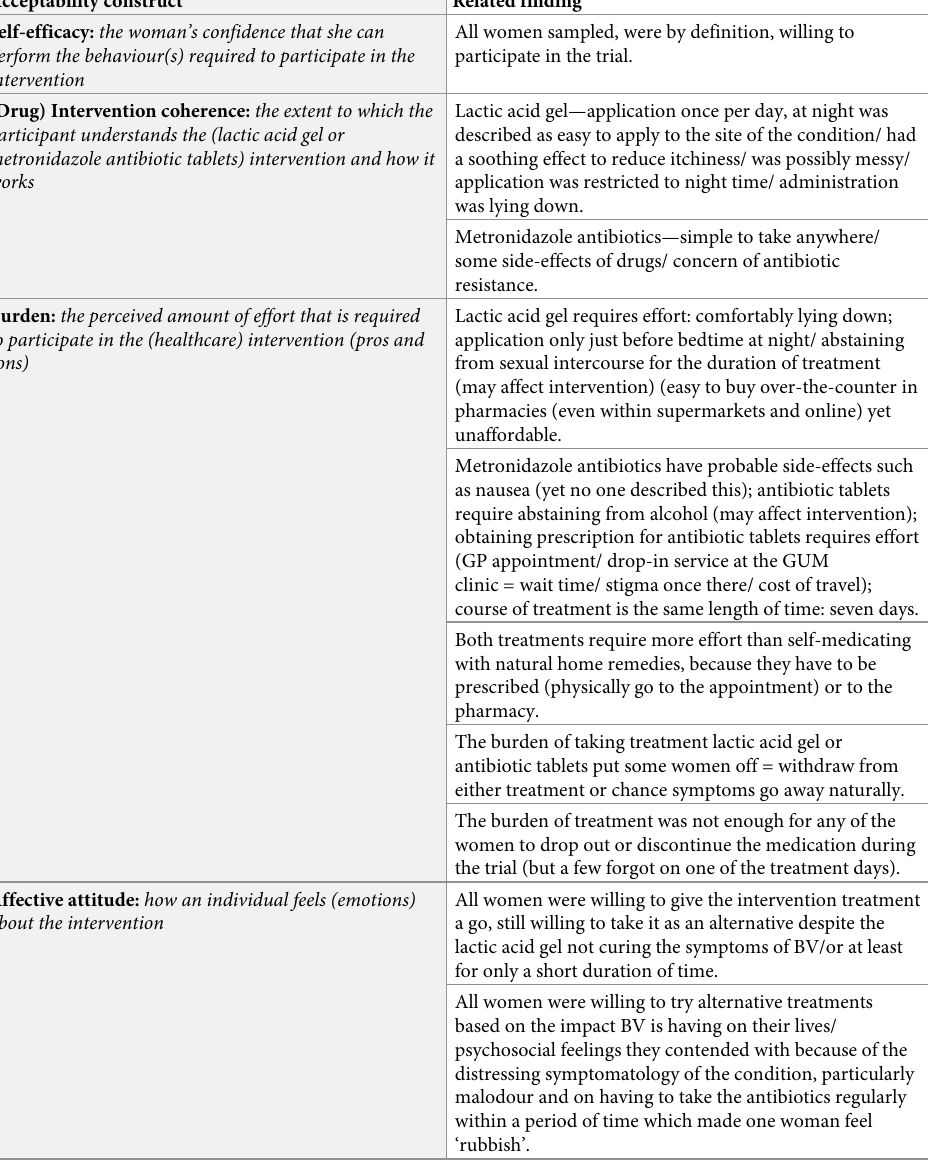
Table 1. Related finding to the acceptability construct from the ‘acceptability of health interventions’